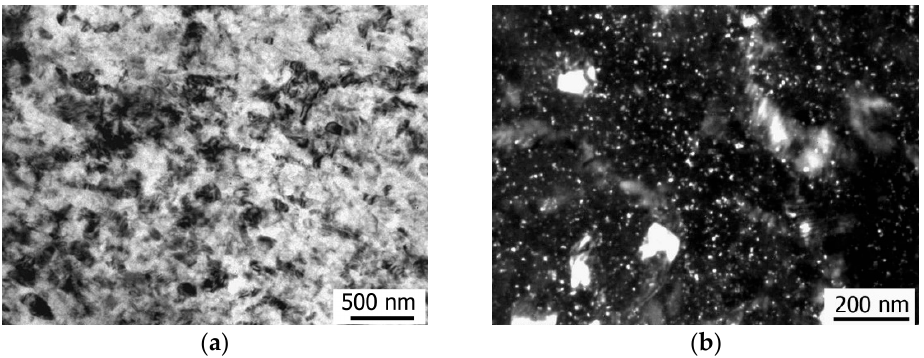
Figure 8. Structure of the Mg-1Zn-0.2Ca alloy after HPT processing: ( a ) bright-field image; ( b ) dark-field image showing dispersed particles.